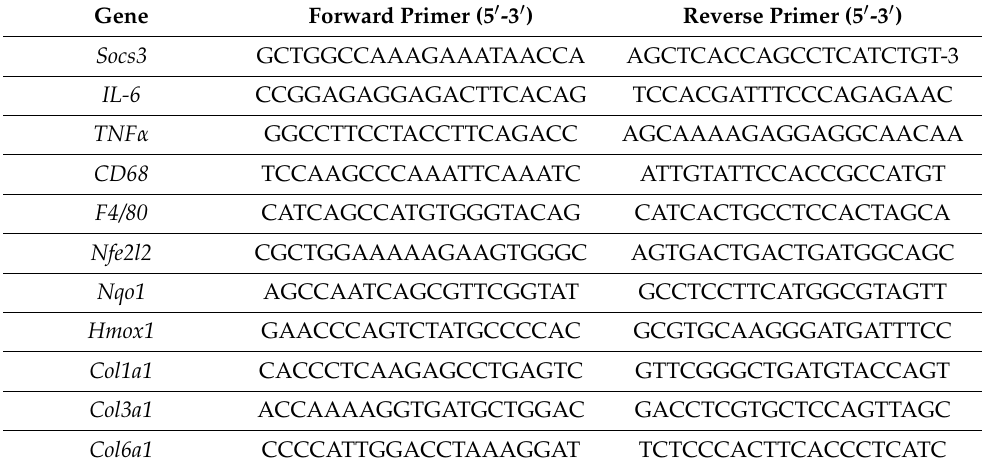
Table 1. Primer sequences used for PCR